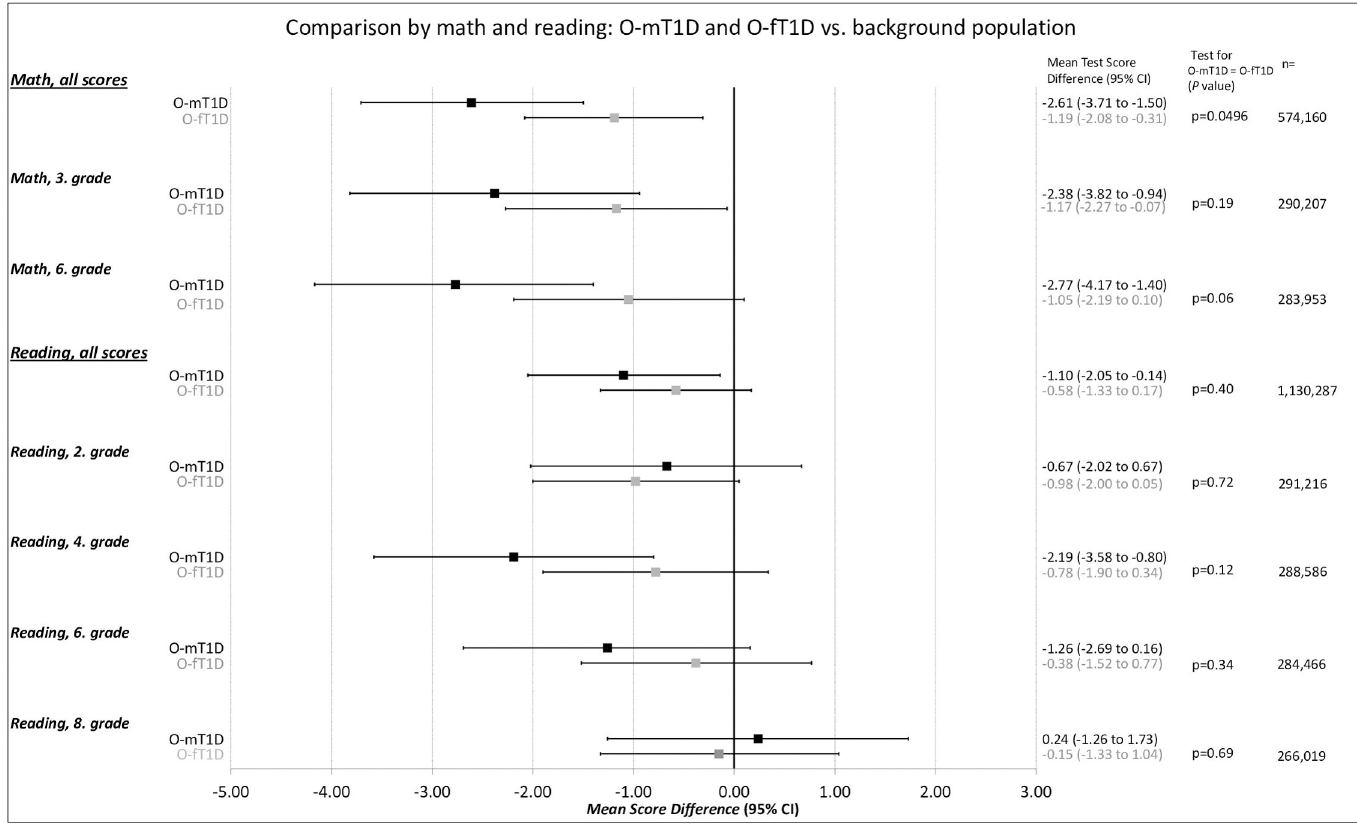
Fig 1. Multiple linear regression analyses comparing test scores in math or reading in offspring of mothers (O-mT1D) and fathers (O-fT1D) with type 1 diabetes compared with O-BP, mean test score difference (95% CI). Notes: Differences are adjusted for grade-, topic-, and year-specific fixed effects, offspring sex, parity, number of siblings, offspring with type 1 diabetes, maternal smoking during pregnancy, parental highest educational level, income, immigrant or descendant status, age, and parents living together (corresponding to Model 3). p -Value from Wald test (F-test) of equality of the regression coefficients to O-mT1D and O-fT1D is reported. O AU : AnabbreviationlisthasbeencompiledforthoseusedthroughoutFig 1 : Pleaseverifythatallentriesarecorrect :